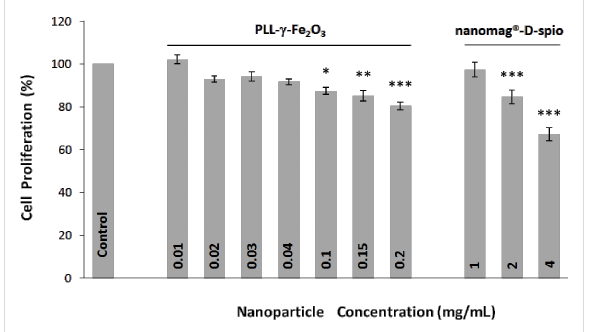
Figure 4: PLL- γ -Fe 2 O 3 nanoparticles did not affect NSC proliferation. MTT cell viability assay of NSCs labeled with PLL- γ -Fe 2 O 3 and nanomag ® -D-spio nanoparticles ( N = 12). The statistically significant diferences versus Control were depicted by asterisks, *: P <